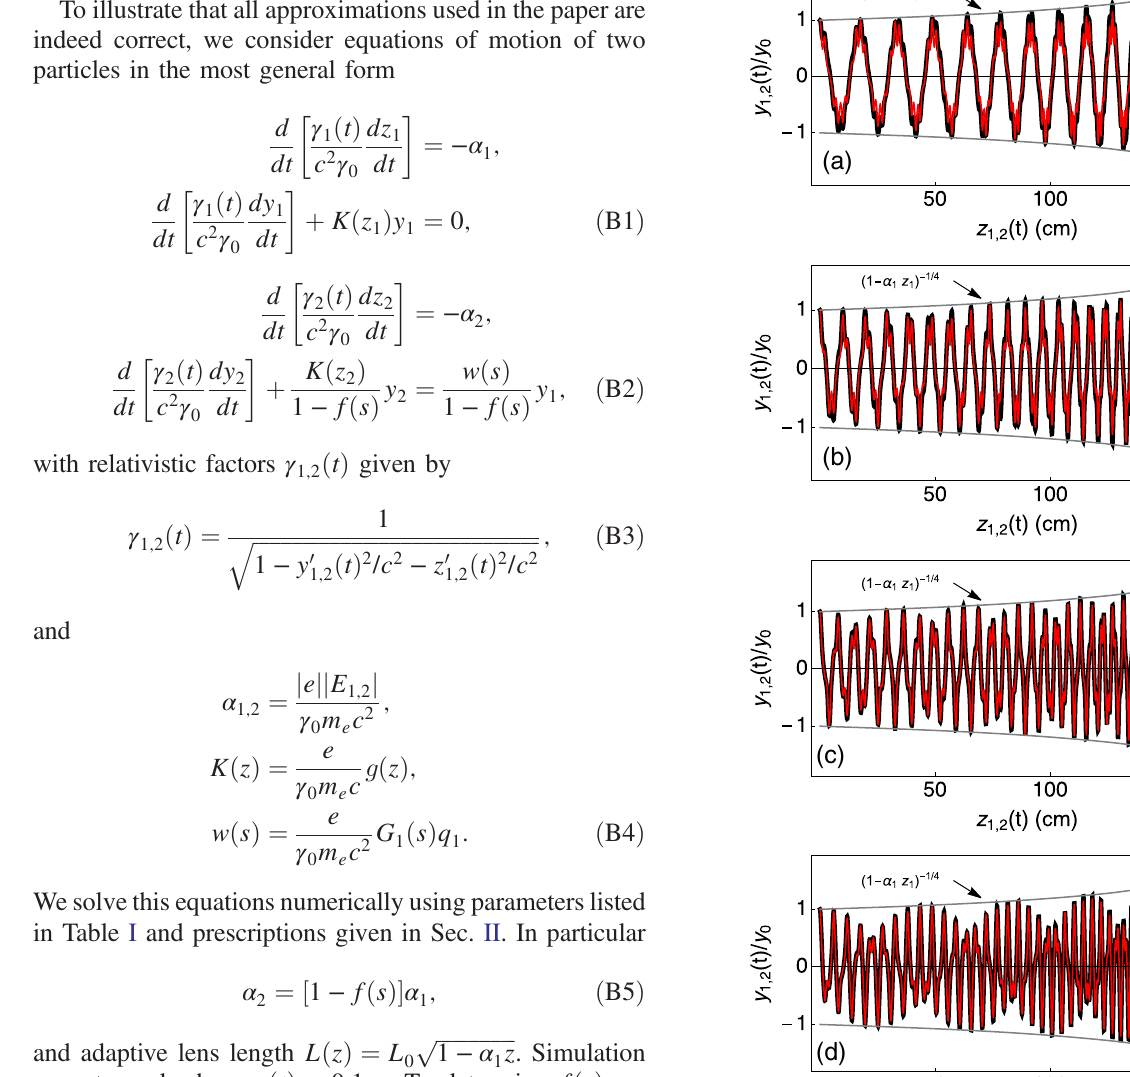
and adaptive lens length L ð z Þ ¼ L 0